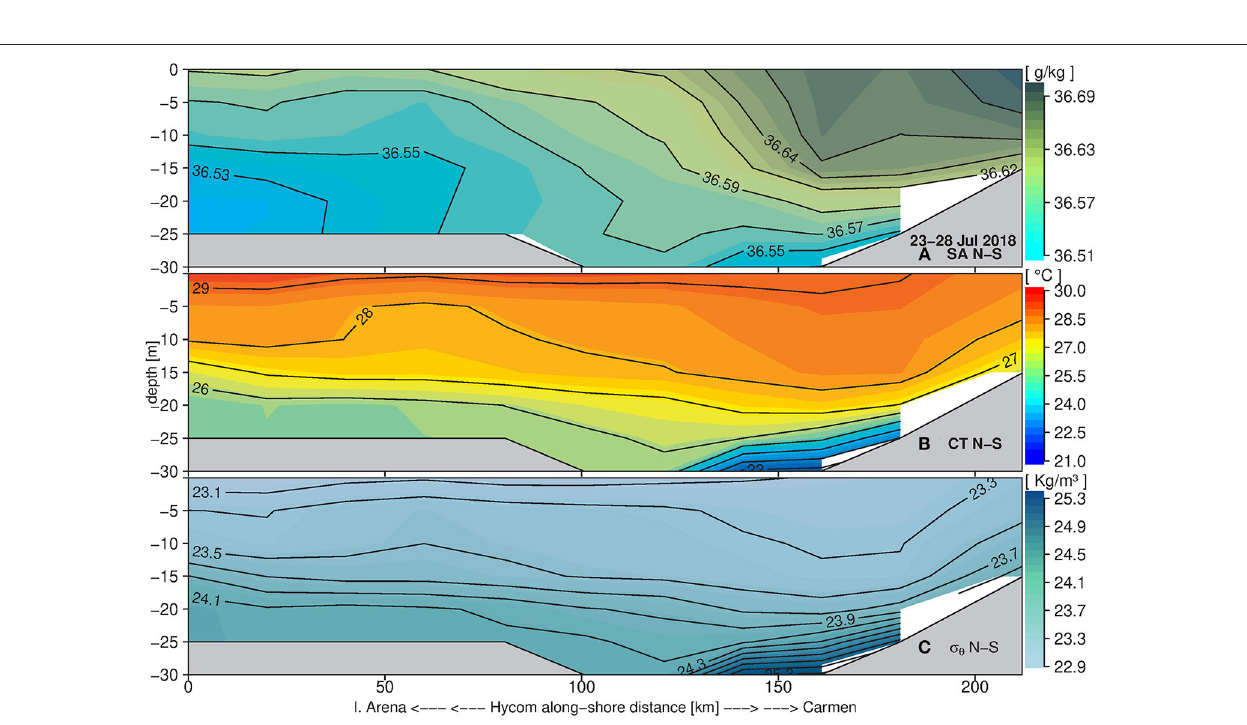
FIGURE 7 | Along-shore view of the vertical distribution of (A) absolute salinity (g/kg), (B) conservative temperature ( ◦ C), and (C) density ( σ θ in kg/m 3 ), from north to south, extracted from the Hycom modeled observations (L Hycom on Figure 1 ).